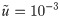
The spatial extent of clones can be much larger than the expectation derived from the average mass.Ensemble-averaged spatial extent of clones 〈rmax〉, where rmax is defined as half the distance between leftmost and rightmost demes belonging to a particular clone. Values are normalized by the ensemble-averaged mass-equivalent radius 〈req〉 in 1D simulations. Each point is an average over values from 20 independent simulations. Dotted lines connect simulation data points. Dashed lines show the theoretical expectations ζ/χ (with u˜=10-3) and ψas/χas in the ranges μ < 1 and 1 < μ < 2 respectively, multiplied by model-dependent numerical factors. For μ < 1, χμ(u˜=10-3) is evaluated as described in S1 Appendix, Section A; for 1 < μ < 2, the ratio ψas/χas is independent of u˜. The fall in the measured ratio at low values of u˜ for μ < 1 is due to finite-size effects, as seen by comparing the two system sizes: the measured values of rmax in this range are below the values that would be measured in an infinitely large system.